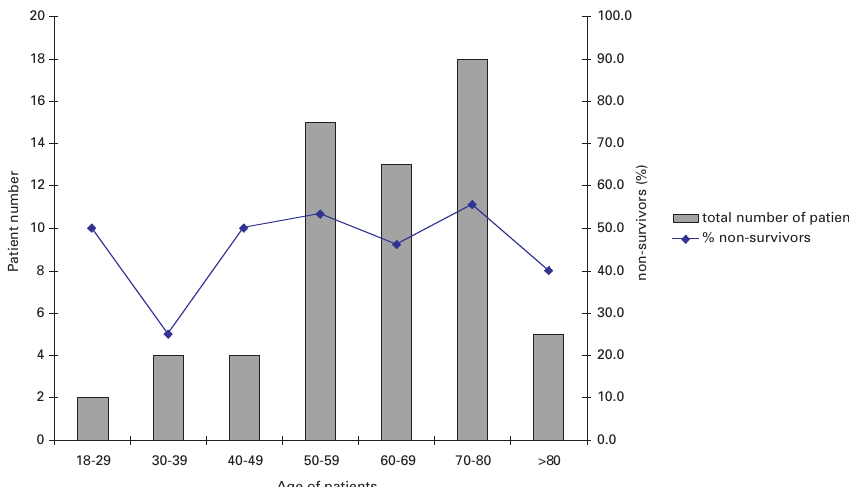
Age distribution of severely septic pa- tients and percentage of